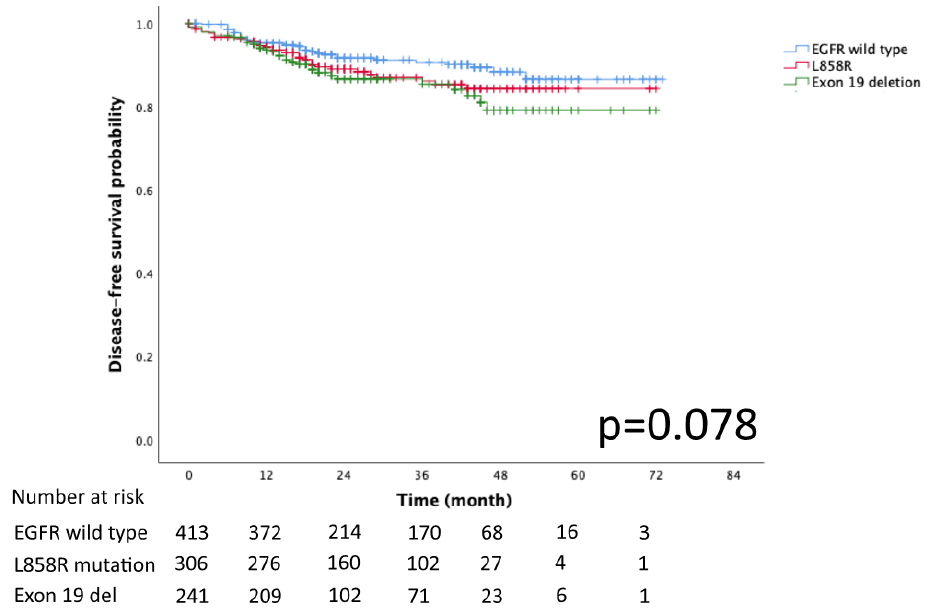
Figure 2. Kaplan–Meier curve of EGFR wild type, Exon 19 del, and L858R disease free Figure 2. Kaplan – Meier curve of EGFR wild type, Exon 19 del, and L858R disease free survival.